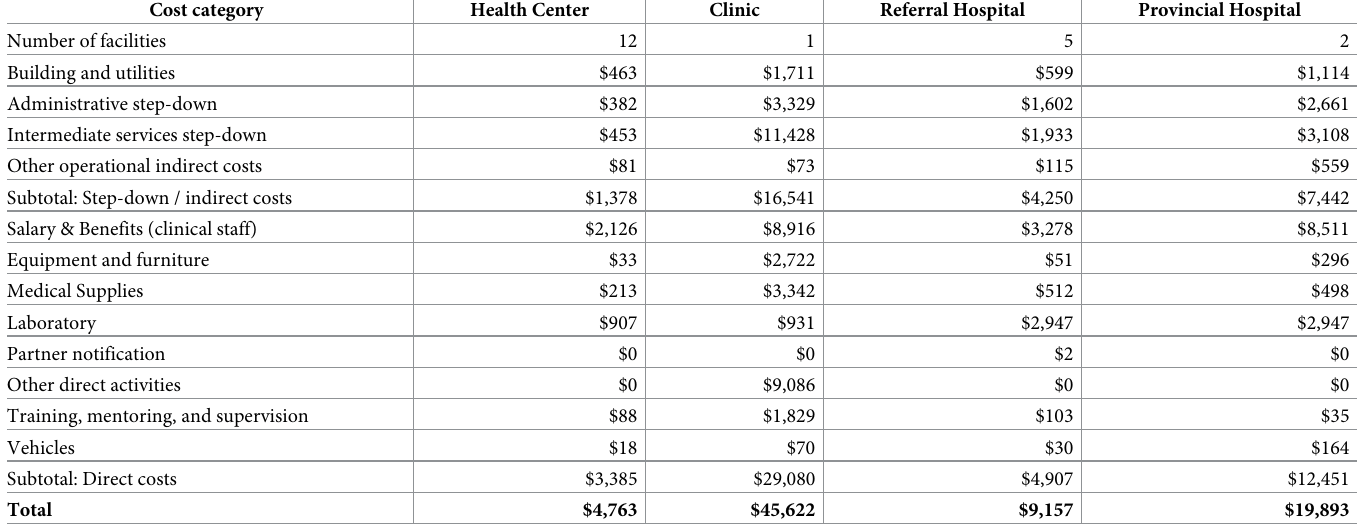
Table 2. Total costs for VCCT services per year, average by type of